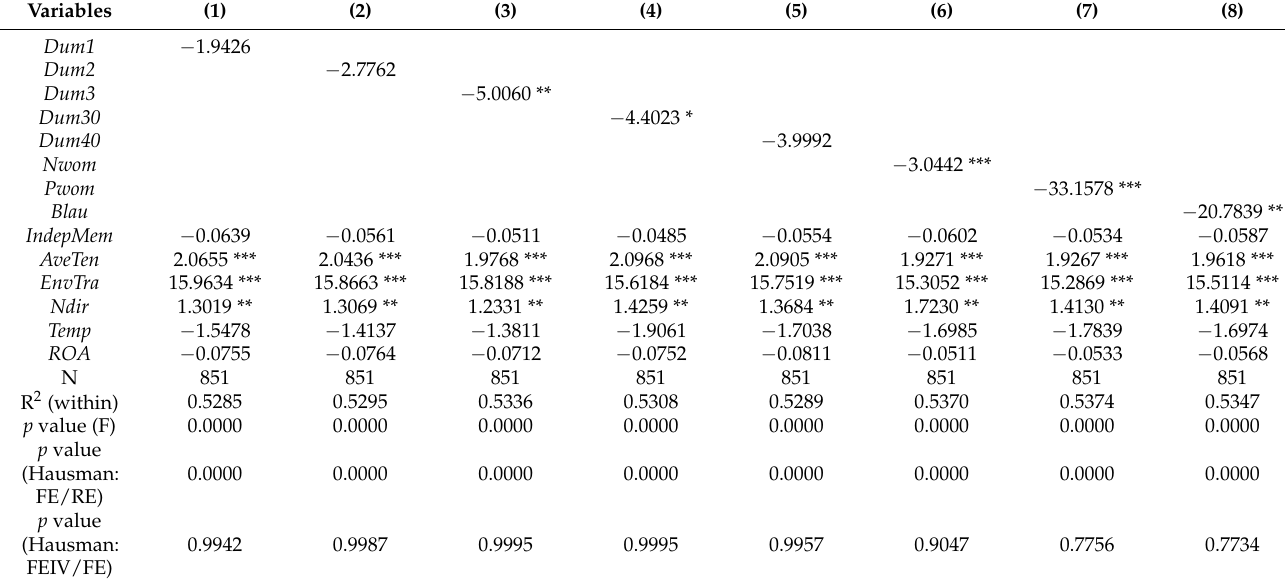
Table 8. Dependent variable: ResUseSc . Fixed effects estimator